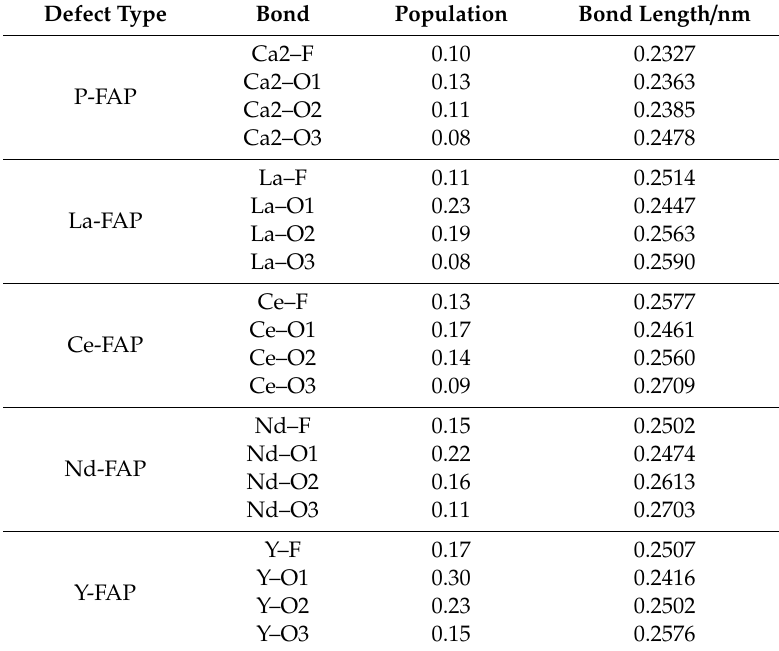
Table 3. Mulliken population of bonds formed between the REE atom and the atoms adjacent to the REE atoms in REE-FAP